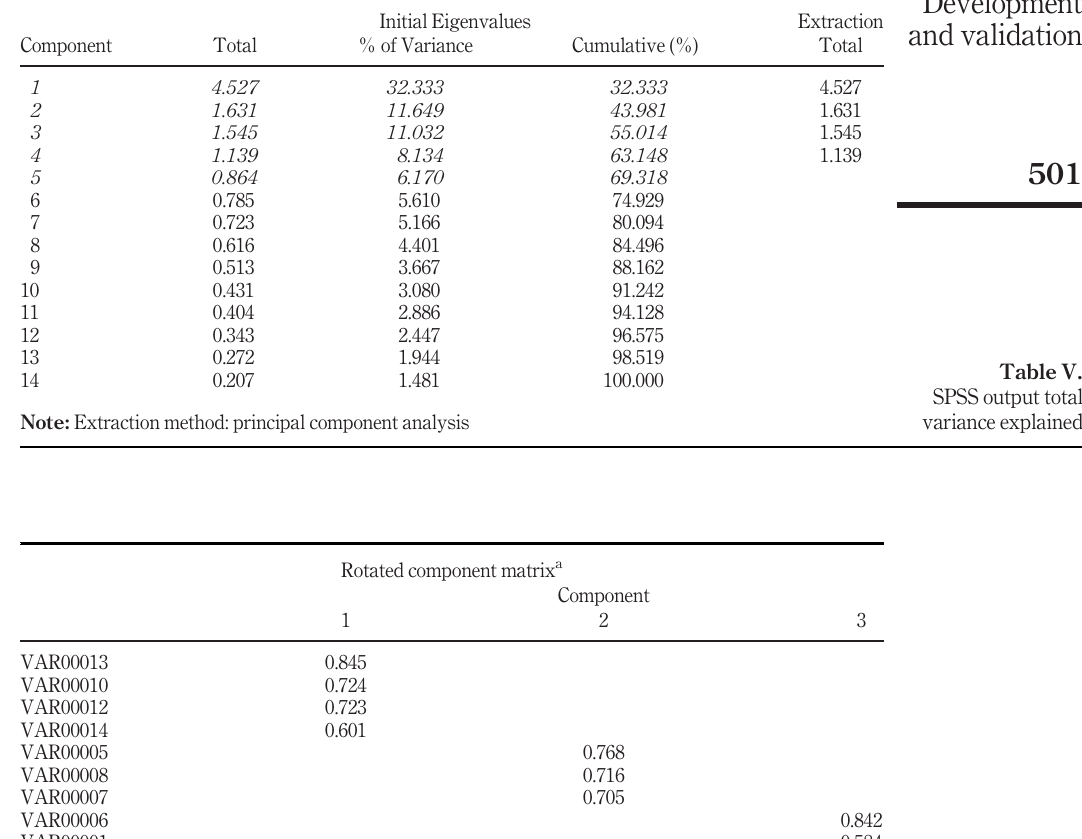
Table VI. SPSS output rotated component (factors or constructs)